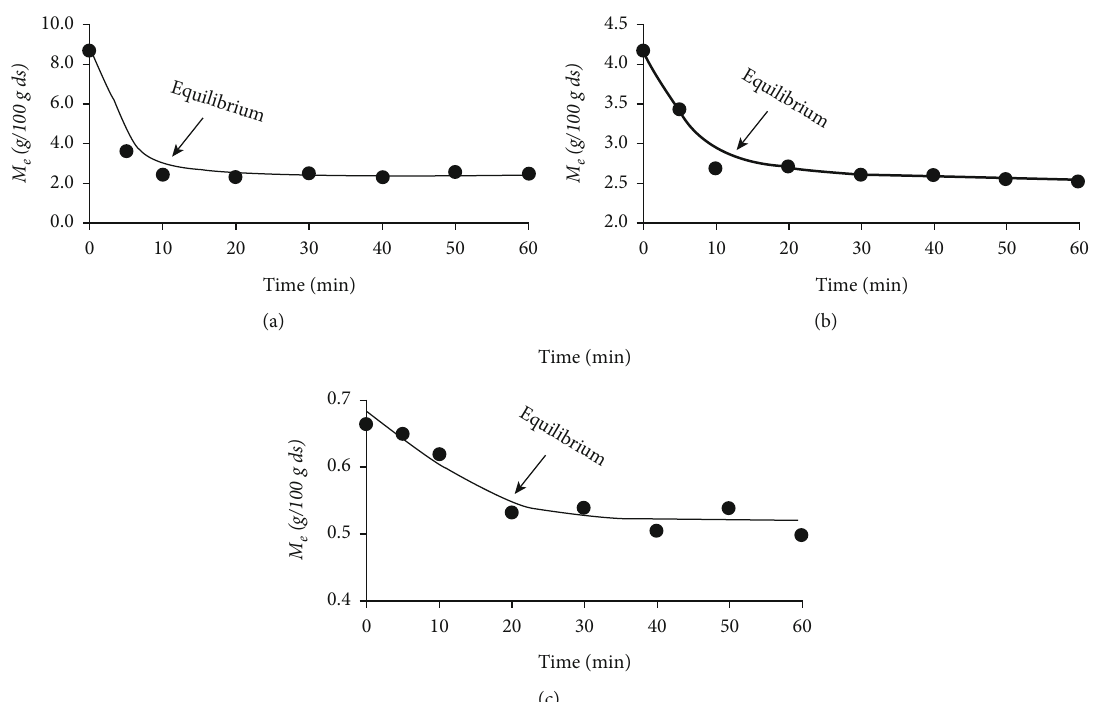
Figure 2: Sorption kinetics of the dried samples for initial conditioning before starting the adsorption isotherm ((a) cellulose, (b) lignin, and (c)